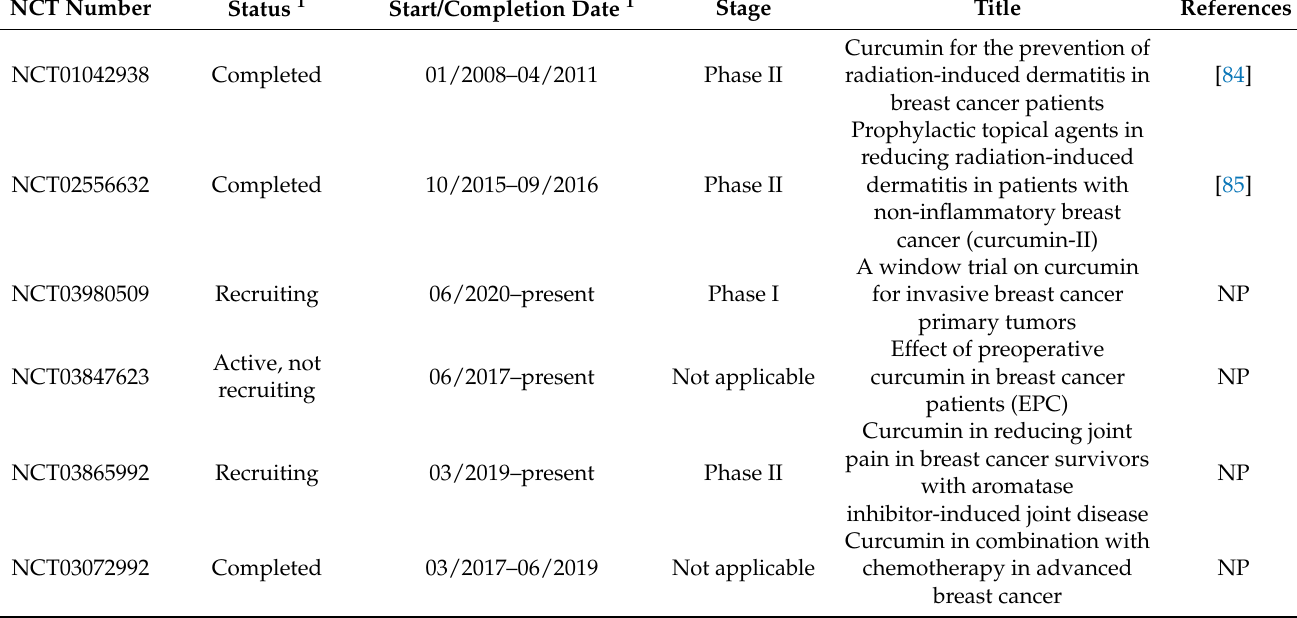
Table 3. Clinical trials with curcumin in breast